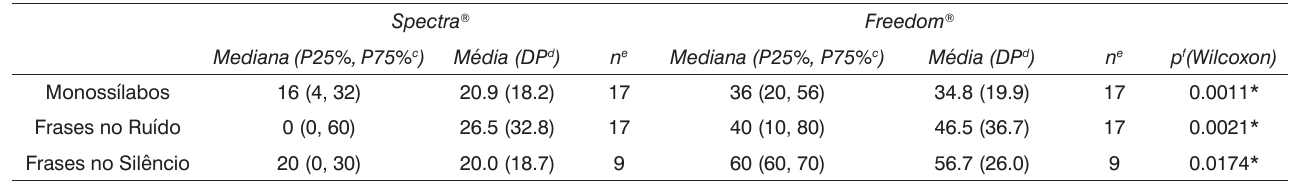
1. Bento RF, Brito Neto RV, Castilho AM, Goffi-Gomez MVS, Sant’Anna SBG, Guedes MC. Resultados auditivos com o implante coclear